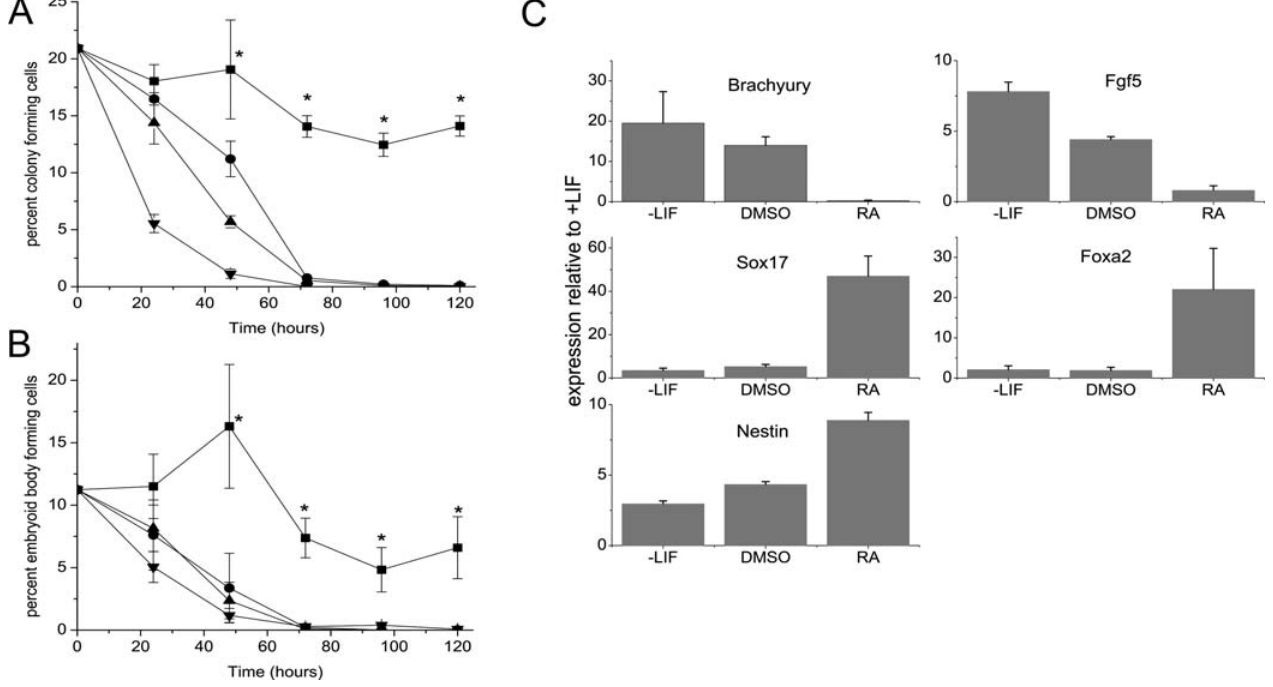
Figure 1. The Effect of LIF Removal with or without Addition of DMSO or RA on the Maintenance and Differentiation of ESC (A) CFC frequency and (B) EB-forming ability of cells from the ESC cultures assessed at varying times after initiation of the treatment ( þ LIF controls ¼ & , – LIF ¼ (cid:1) , –LIF þ DMSO ¼ m , þ LIF þ RA ¼ . ). * denotes the data for the þ LIF sample are significantly different from all other treatments. (C) Gene expression of differentiation markers was monitored by Q–RT–PCR after 96 h of treatment. Results shown are relative to the þ LIF control cells. doi:10.1371/journal.pcbi.0020158.g001 PLoS Computational Biology |